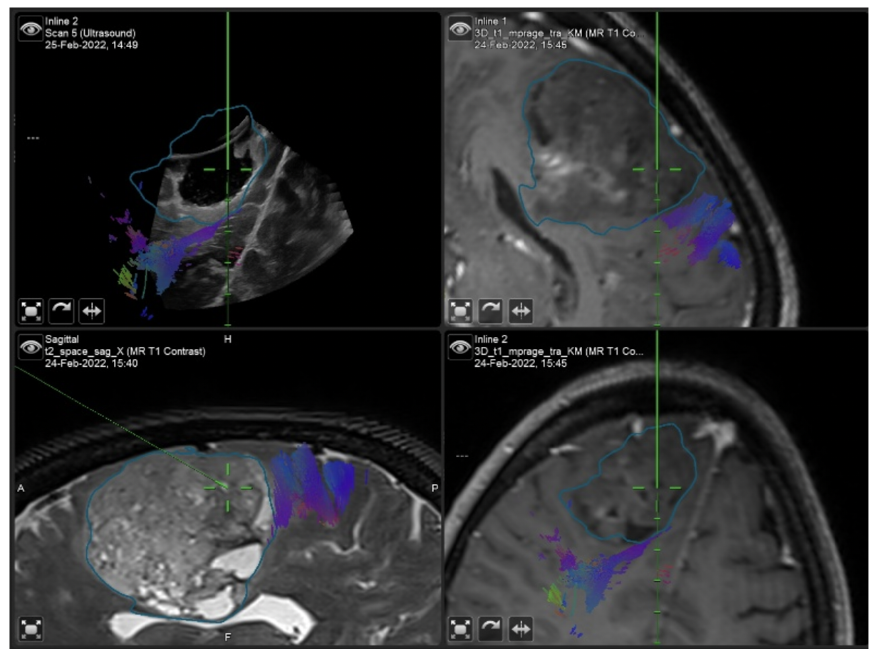
Figure 9. “live” iUS-guided resection before iMRI scan. Note how the cortical spinal bundle high- lighted in violet was spared from the resection area.